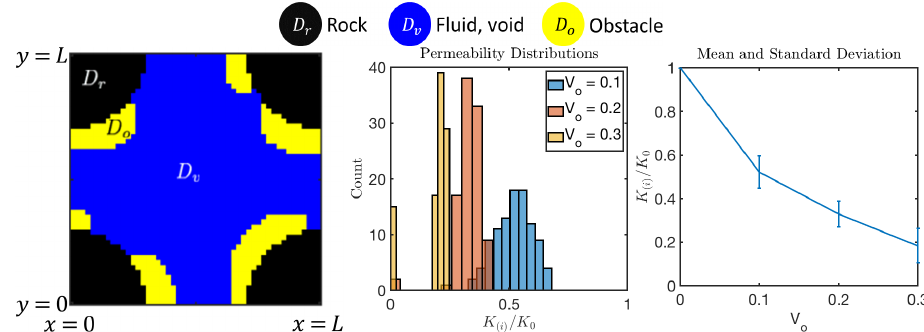
Figure 20. Results of CLPS model for biofilm-like obstructions from Section 6.1.1. Left: one of the ( i ) = 0.2. Middle and right show the experimental probability distribution of realizations of D o for V o ( K ) ( i ) i for three values of V o .